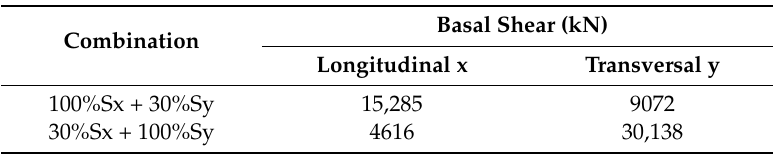
Figure 12. Seismic combination 100%Sx + 30%Sy: ( a ) direction x, ( b ) direction y; seismic combination 30%Sx + 100%Sy: ( c ) direction x, ( d ) direction y.